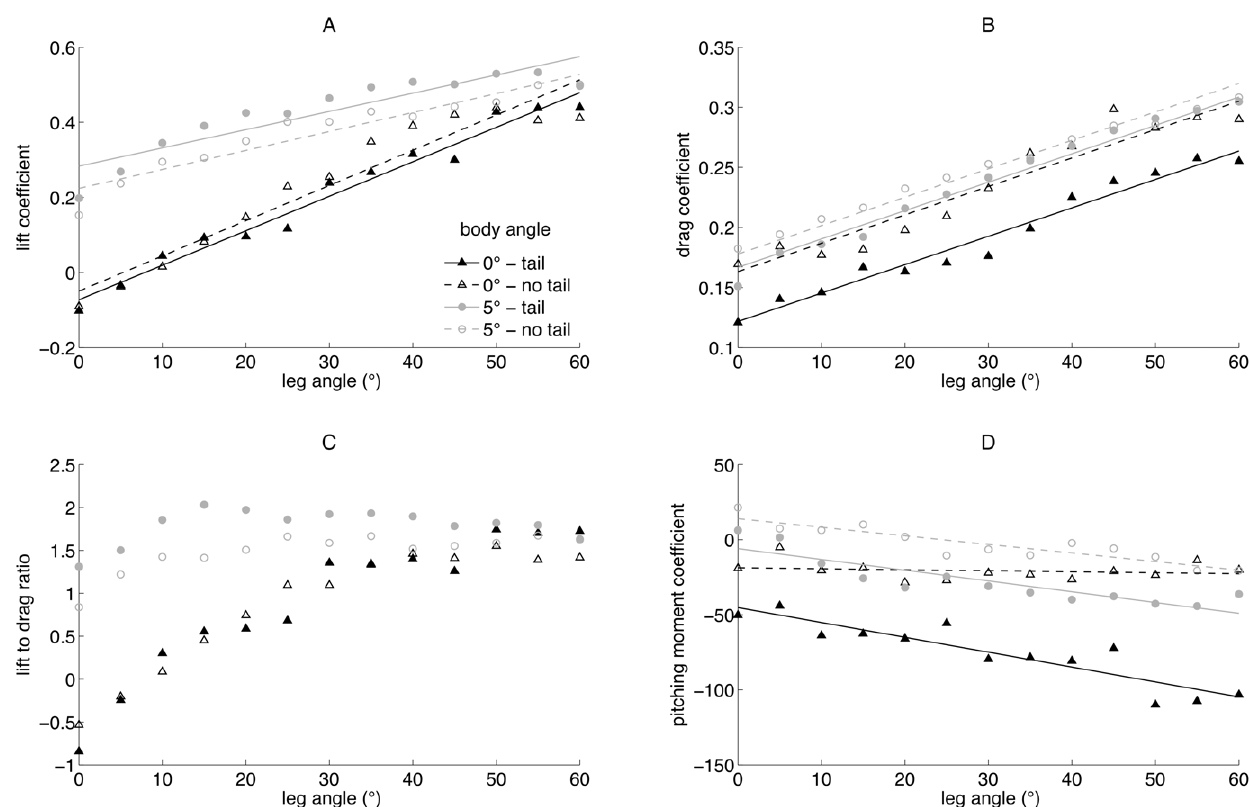
Figure 4. Comparison of the bat model’s aerodynamic coefficients with and without a tail membrane. Lift coefficient (A), drag coefficient (B), lift to drag ratio (C) and pitching moment coefficient (D) produced by bat model for two body angles (0 u and 5 u ) at all leg angles, with and without a tail membrane. Solid lines represent model with tail membrane. Dashed lines represent model without tail membrane. Black lines are for body angle of 0 u and grey lines for 5 u .